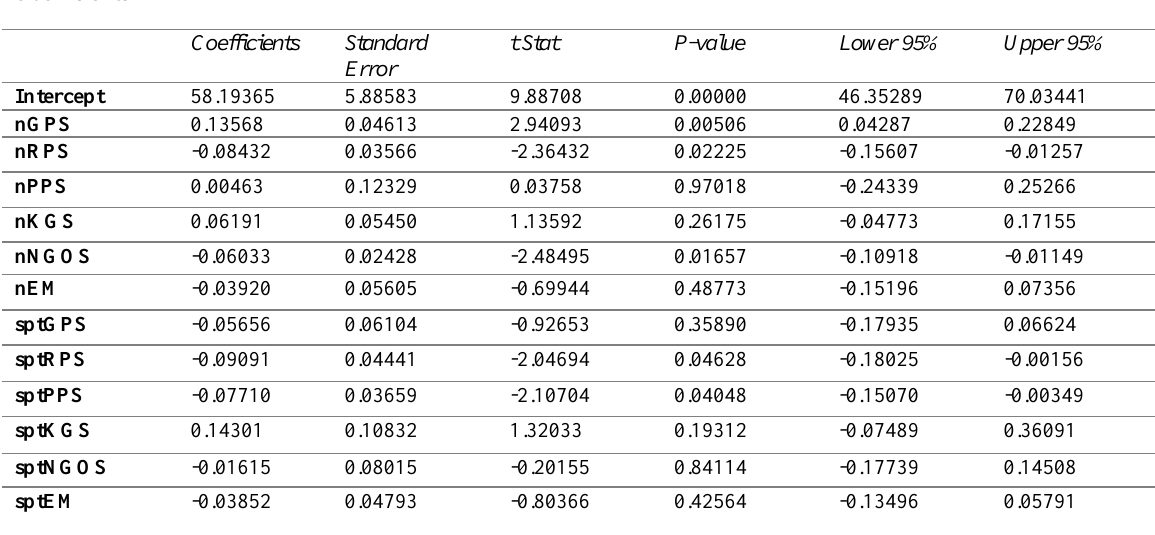
Table 15 : Coefficients (Khulna